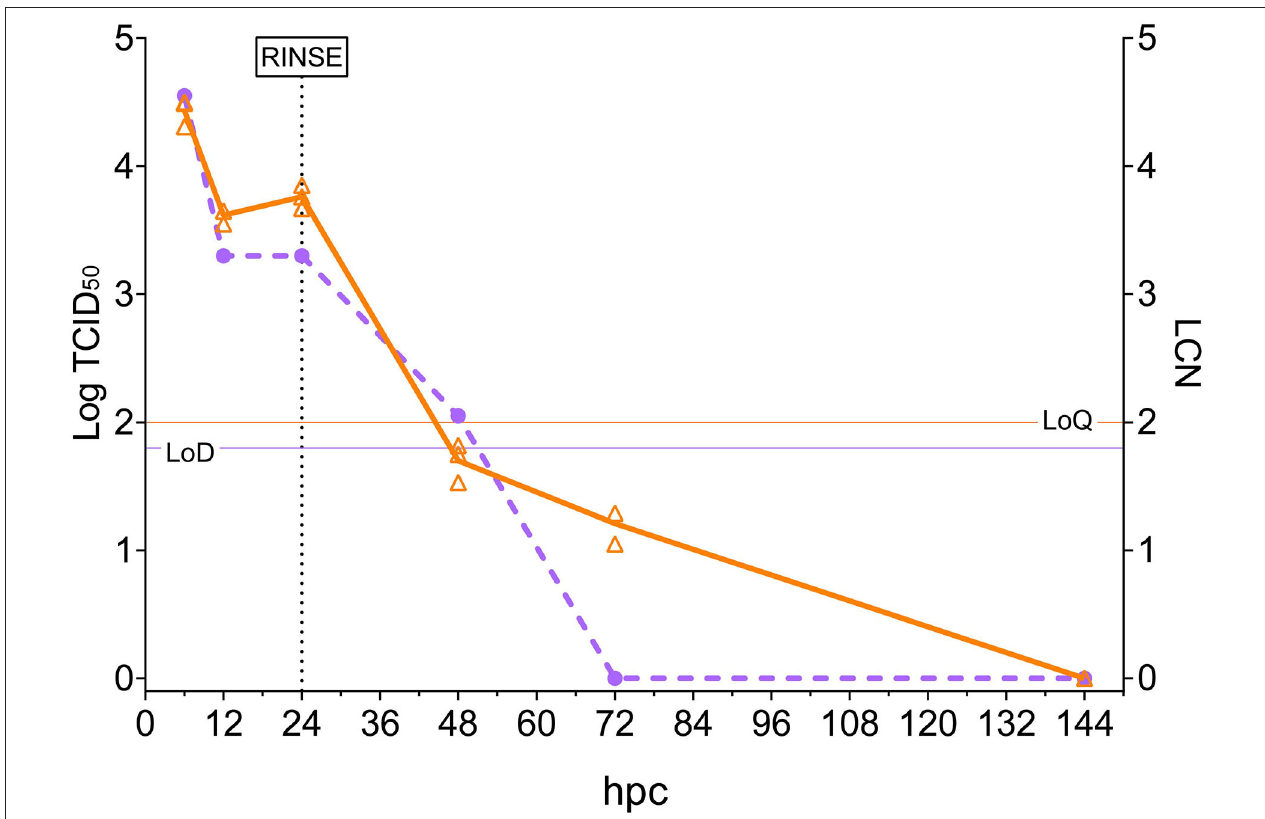
FIGURE 1 | Rotifer nervous necrosis virus (NNV) challenge. The x -axis represents the observation period expressed as hours post-challenge (hpc). The left y -axis reports quantified viral loads expressed as Log 10 of TCID 50 /ml, and values are depicted as circles. A dashed purple line shows the trend of TCID 50 /ml in time. The right y -axis reports quantified viral load expressed as LCN/100 µ g, and values are depicted as triangles (three biological replicates for each sampling). A solid orange line shows the trend of mean LCN values in the time. Thin horizontal lines represent the limit of detection (LoD) or the limit of quantification (LoQ) of the methods. The vertical dashed line indicates the time in which NNV-exposed rotifers were rinsed and started their housing in NNV-free